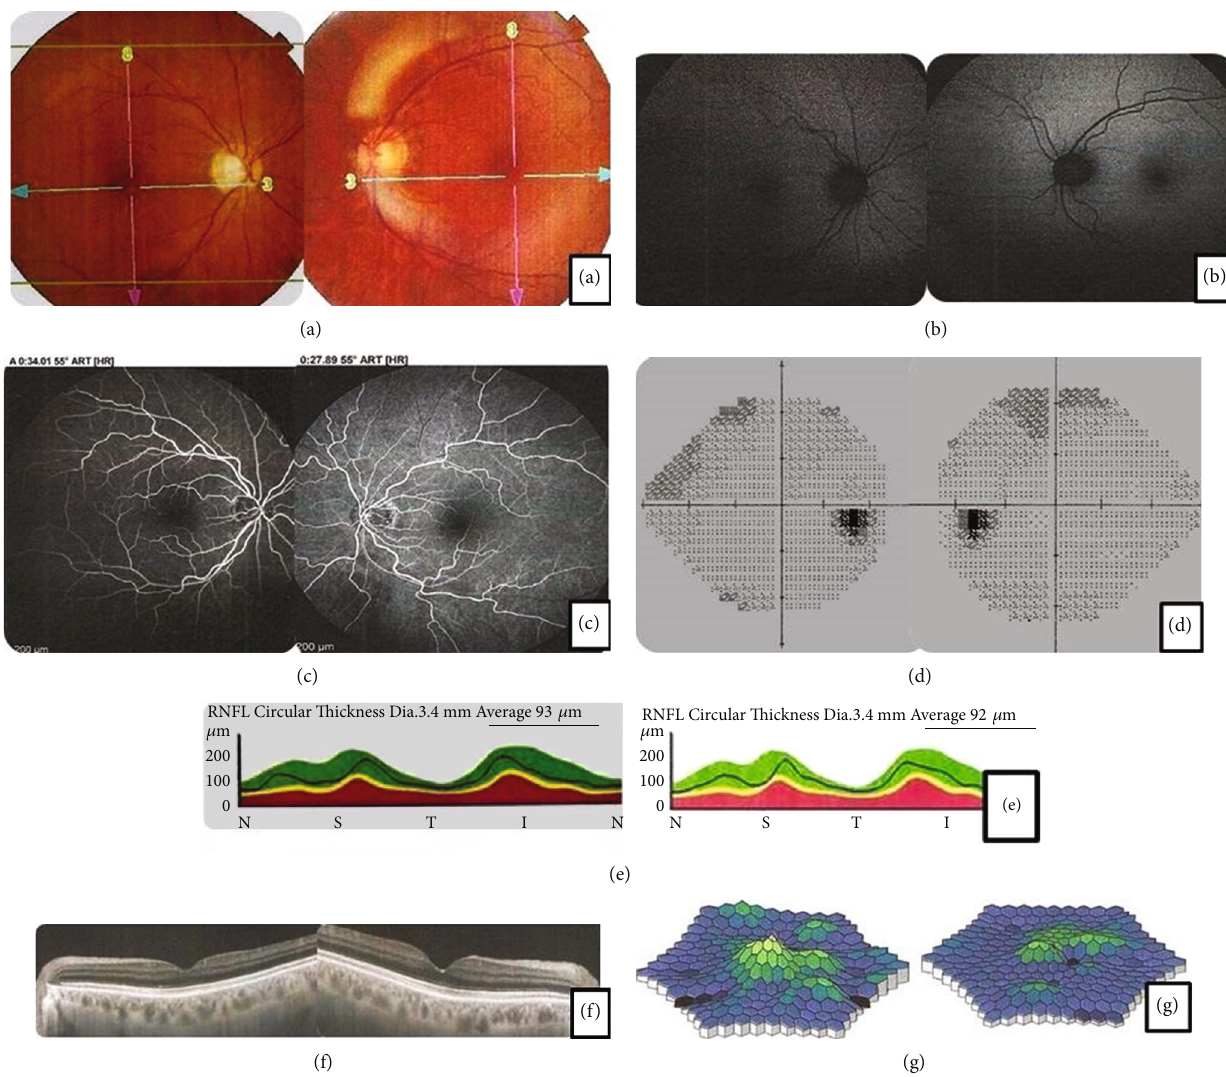
Figure 2: Retinography (a) and FA (c) showed important arterial narrowing. IVFA (b) showed no alterations. Humphrey visual fi eld (d) showed diminished bilateral nasal sensitivity. Optic disc and macula OCT (e, f). ERG (g) showed diminished bilateral